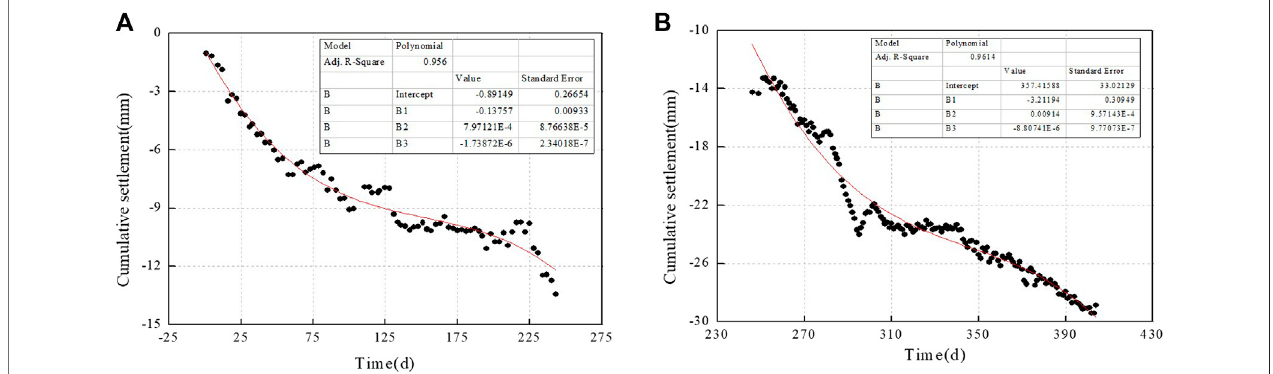
FIGURE 8 | Data change curve fi tting diagram. (A) phases I; (B) phases